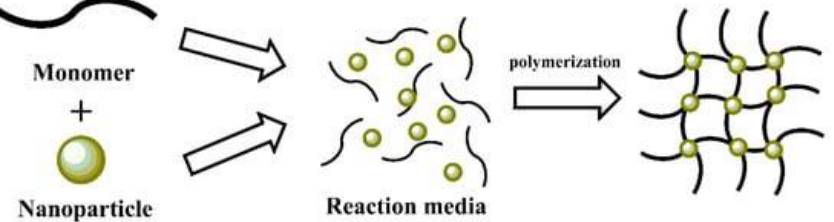
Figure 5. Schematic representation of in situ polymerization method. Reprinted with permission from ref. [57], MDPI, 2022.